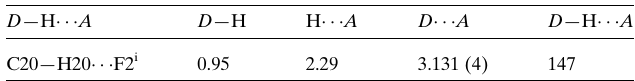
Table 1 Hydrogen-bond geometry (A˚ , (cid:5) ).